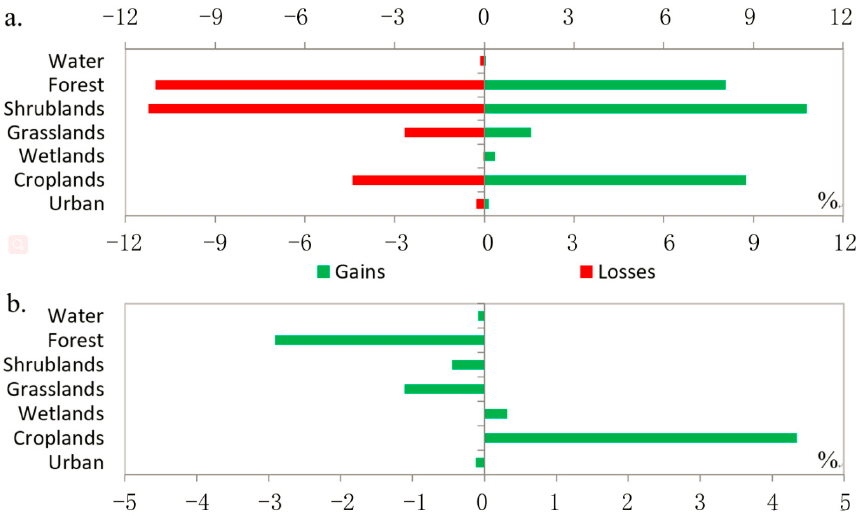
Figure 3. ( a ) Gains and losses in land cover between 2001 and 2008; ( b ) Net land cover change between 2001 and 2008.